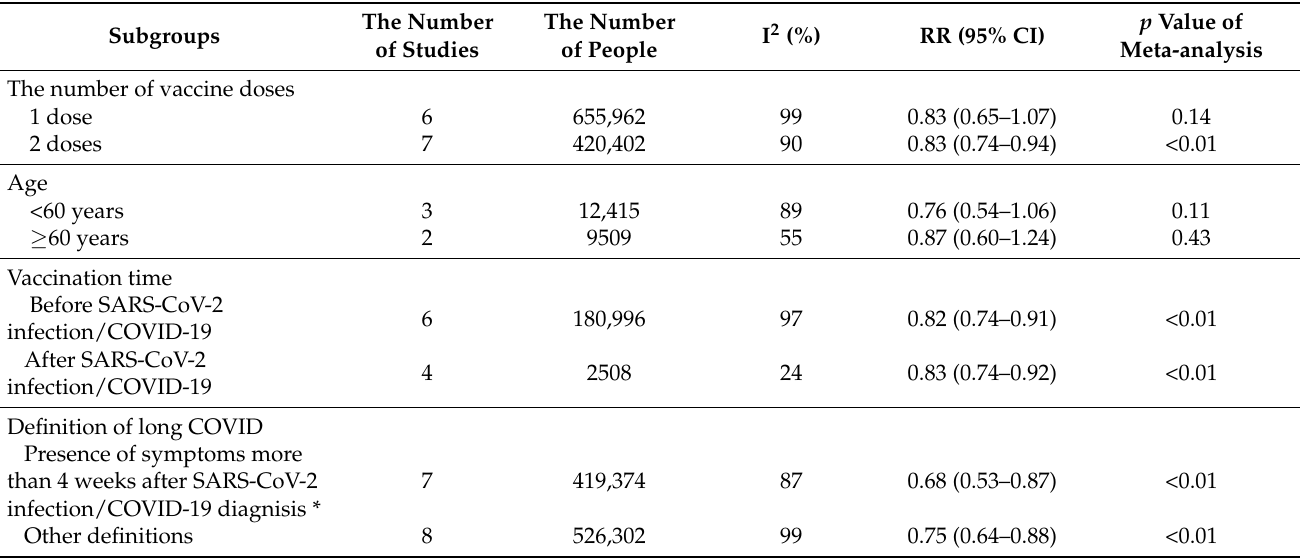
Table 2. Results of the subgroup analysis of the effect of vaccination on long COVID.